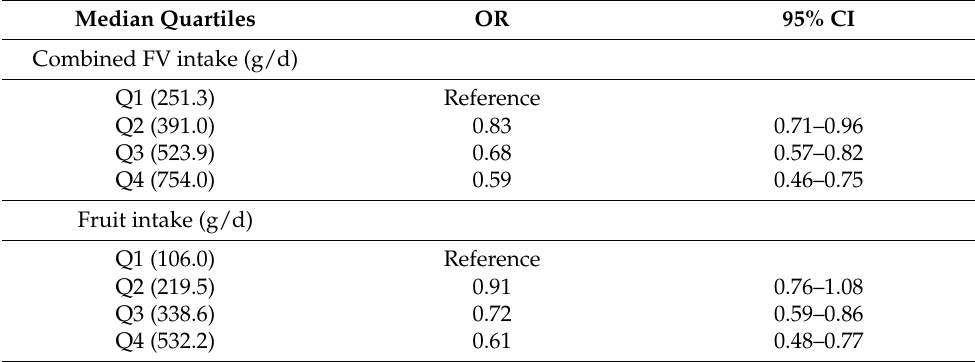
Figure 2. Graphic presentation from multivariable-adjusted general linear models of the longitudinal relationship between baseline intakes of ( a ) FV combined, ( b ) fruits, ( c ) vegetables, ( d ) DF from FV, ( e ) RS from FV, in g/day, with 5 year MCS scores in 5845 Australian adults from the AusDiab study. Models were adjusted for age, sex, BMI, energy intake, relationship status, physical activity, level of education, the socio-economic index for areas (SEIFA), diabetes and self-reported prevalence of CVD. The blue shaded areas represent 95% confidence intervals, the rug plot along the bottom of each graph represents each dietary intake observation. DF, dietary fibre; FV, fruit and vegetables combined; MCS, SF-36 Quality of Life Scale—Australian norm-based mental component score median; RS, resistant starch. Table 2. Association of baseline intakes of FV, fruit, vegetable, DF from FV and RS from FV, with 5-year MCS scores in 4 067 Australian adults from the AudDiab study (excludes those with baseline MCS score <